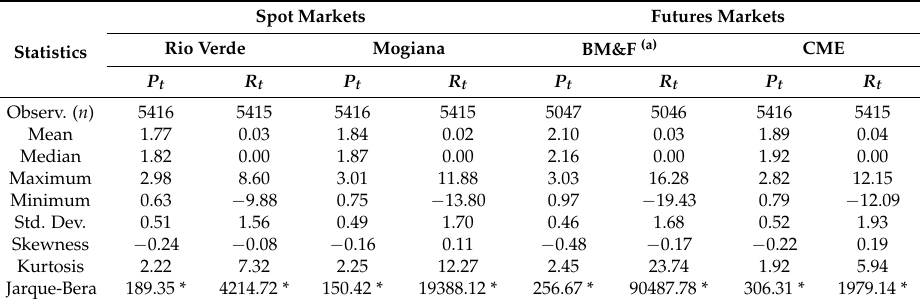
Table 3. Descriptive statistics of daily log prices ( P t ) and returns ( R t ) (June 1995–June